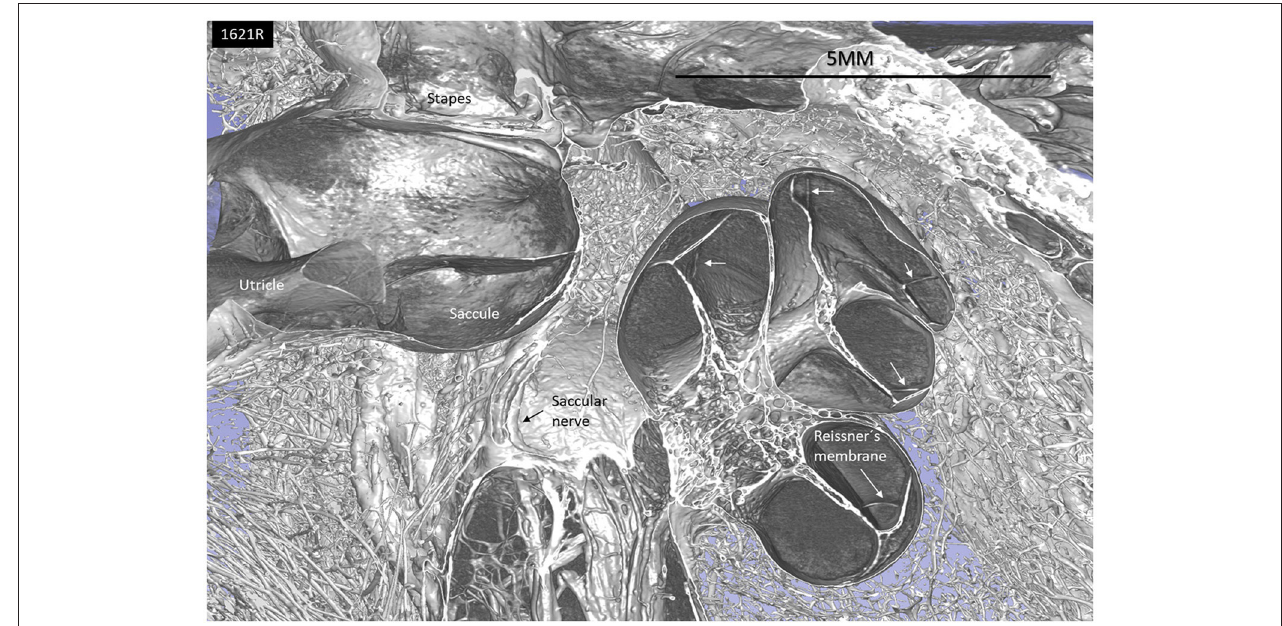
FIGURE 1 | SR-PCI and 3D reconstruction of a left human inner ear (superior view) using 3D slicer (version 4.10; www.slicer.org). The cochlea, utricle, saccule, and saccular nerve are seen with cranial nerves in the fundus of the IAC.